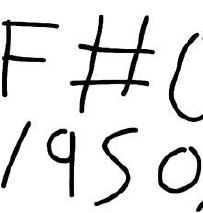
Figure 1. Sample of handwritten password in secure password-DB-150.